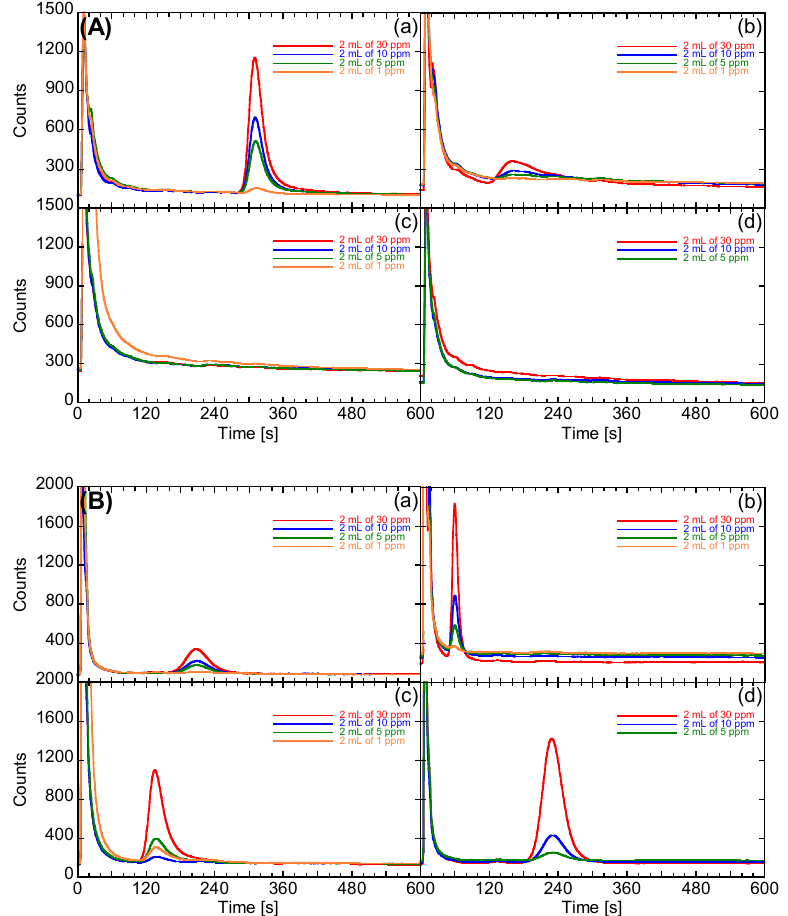
Figure 6. GC spectra from ( A ) column 1 and ( B ) column 2 of the prototype system used for analysis of several concentrations of: ( a ) nonanal; ( b ) acetoin; ( c ) acetic acid; and ( d ) propanoic acid. The condensed amounts of two milliliters of 1, 5, 10, and 30 ppm were almost the same as that of 200 mL (exhaled breath analysis) of 10, 50, 100, and 300 ppb VOCs, respectively.